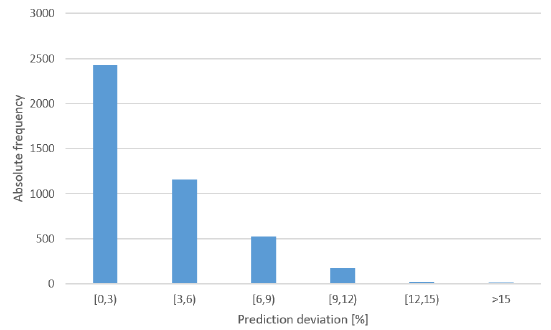
Figure 13. Histogram of the prediction error of the ultimate tensile strength for all iterations.